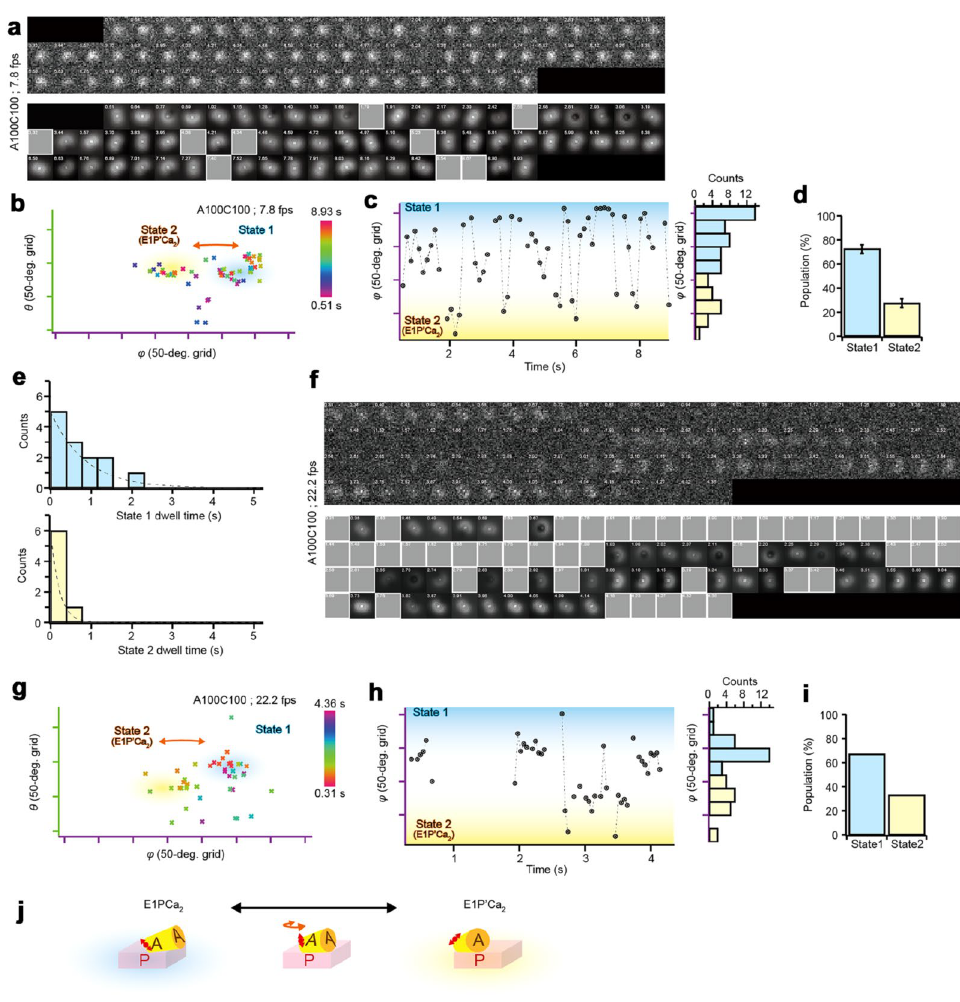
Figure 5. High-speed measurement of the ATP dependent angle change of the SERCA1a A-domain. ( a ) Sequential defocused images of a fluorophore at 100 µM Ca 2+ and 100 µM ATP (A100C100; cf. Supplementary Video 2). Time scale described in upper left of each image is in seconds. ( Upper panel ) Experimental images were taken at 128 ms intervals. ( Lower panel ) Reconstructed images represent the diffraction pattern rendered using the angles derived from the matching algorithm. Frames covered with gray square are eliminated frames where the matching algorithm failed to estimate angles or estimated incorrect values. ( b ) The θ and φ angles of the fluorophore at 100 µM Ca 2+ and 100 µM ATP. The color of each point represents the time, as shown in the color bar. Note that the θ and φ angles are relative because the orientation of the SERCA1a molecule in a nanodisc is stable but not controlled in our system. ( c ) Time course of the φ angle of the fluorophore. ( Right ) Histogram of φ angle. Cyan and yellow bars represent States 1 and 2, respectively. ( d ) Populations of States 1 and 2 ( n = 3 molecules). ( e ) Histograms of the dwell time of State 1 and State 2. ( Upper ) Dwell time of State 1 ( n = 13 dwells from 3 molecules). Dotted line indicates exponential fits of which the rate constant was ~ 1.2 s −1 . ( Lower ) Dwell time of State 2 ( n = 7 dwells from 3 molecules). Dotted line indicates exponential fits of which the rate constant was ~ 4.8 s −1 . ( f ) Sequential defocused images of a fluorophore at 100 µM Ca 2+ and 100 µM ATP taken at 45 ms intervals (cf. Supplementary Video 3). ( g ) The θ and φ angles of the fluorophore. The color of each point represents the time, as shown in the color bar. Note that the θ and φ angles are relative. ( h ) Time course of the φ angle of the fluorophore. ( i ) Populations of States 1 and 2 ( n = 2 molecules). ( j ) Schematic of the motion of the A-domain, based on the observation in this figure ( a – i) (see “Discussion”